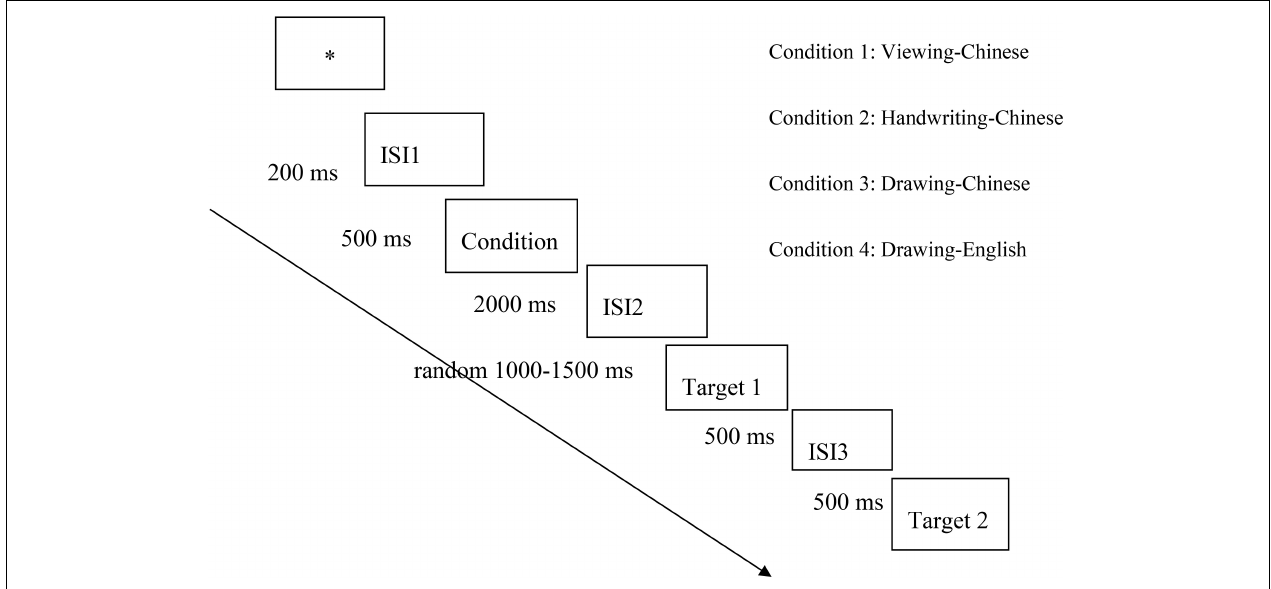
FIGURE 1 | Experimental